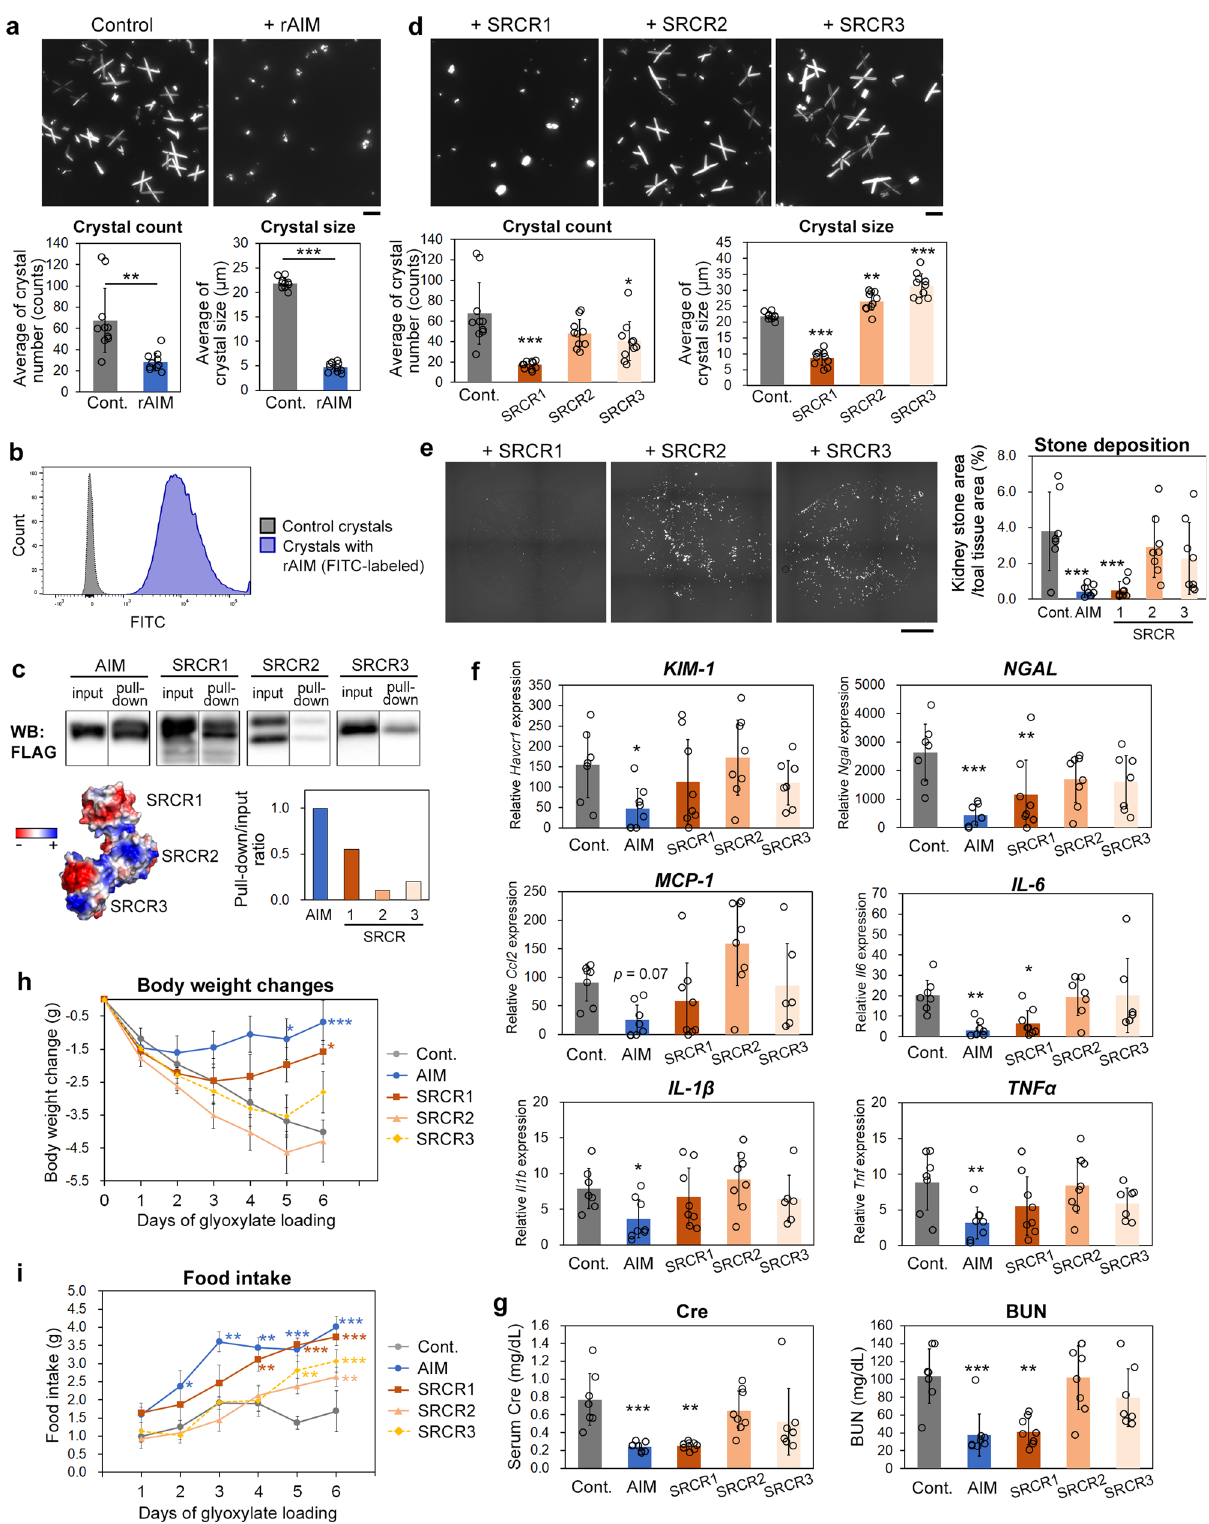
crystal growth in vitro (Fig. 2d). Moreover, intravenous injection of the SRCR1 domain at the equivalent molar level with that of rAIM decreased glyoxylate-induced stone development in mice (Fig. 2e). The mRNA levels of injury markers and in fl ammatory cytokines were reduced in the kidney (Fig. 2f), while serum Cre/ BUN levels (Fig. 2g), bodyweight (Fig. 2h), and food intake (Fig. 2i) were also improved by SRCR1